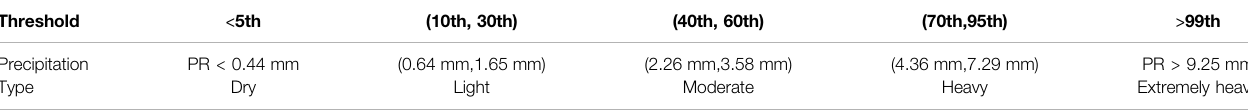
TABLE 3 | Determination of fi ve precipitation